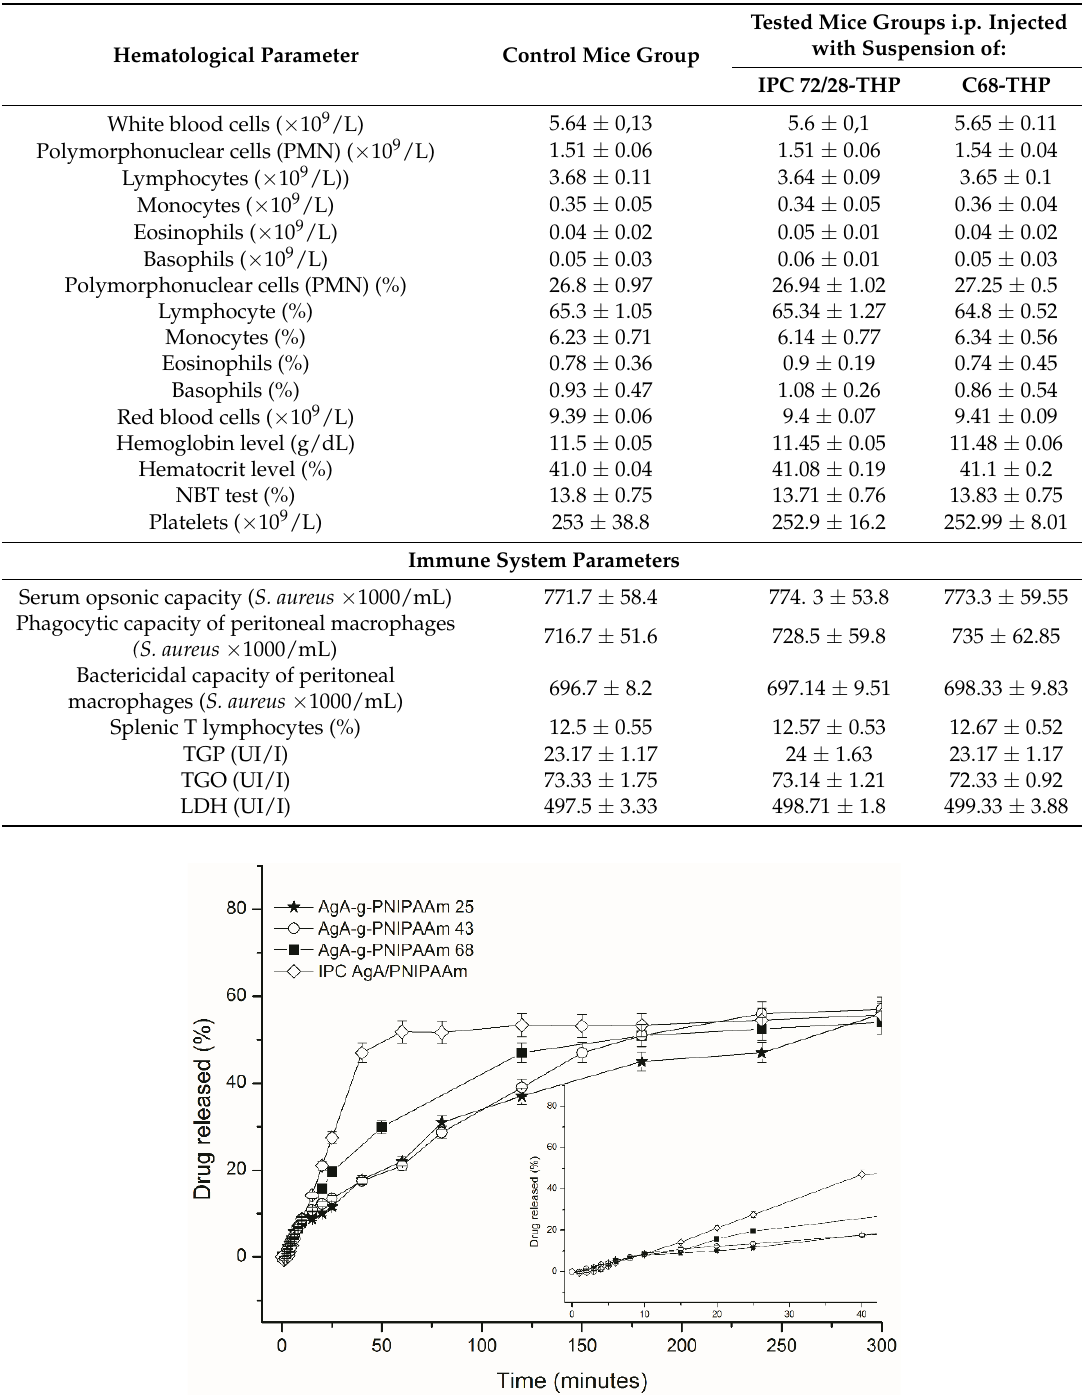
Table 4. Hematological and immune systems parameters.